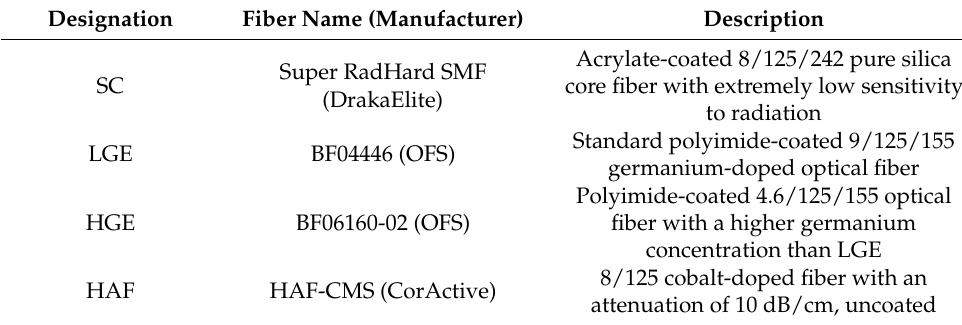
Table 1. Fibers used in the